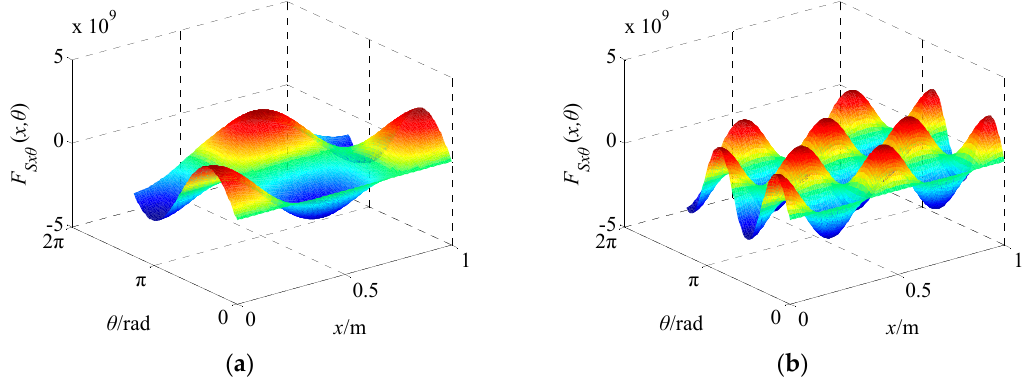
Figure 6. Shear modes of the UUV body structure with ( a ) B(2,1); ( b ) B(4,2).